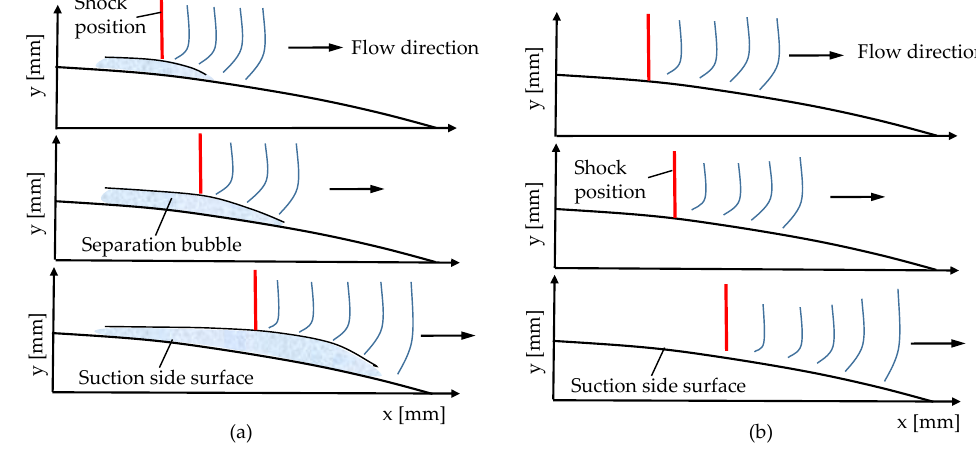
Figure 16. Results of PIV at front shock position (top), mid shock position (middle), and rear shock position (bottom): ( a ) Laminar condition and ( b ) turbulent condition . Reproduced from [77].